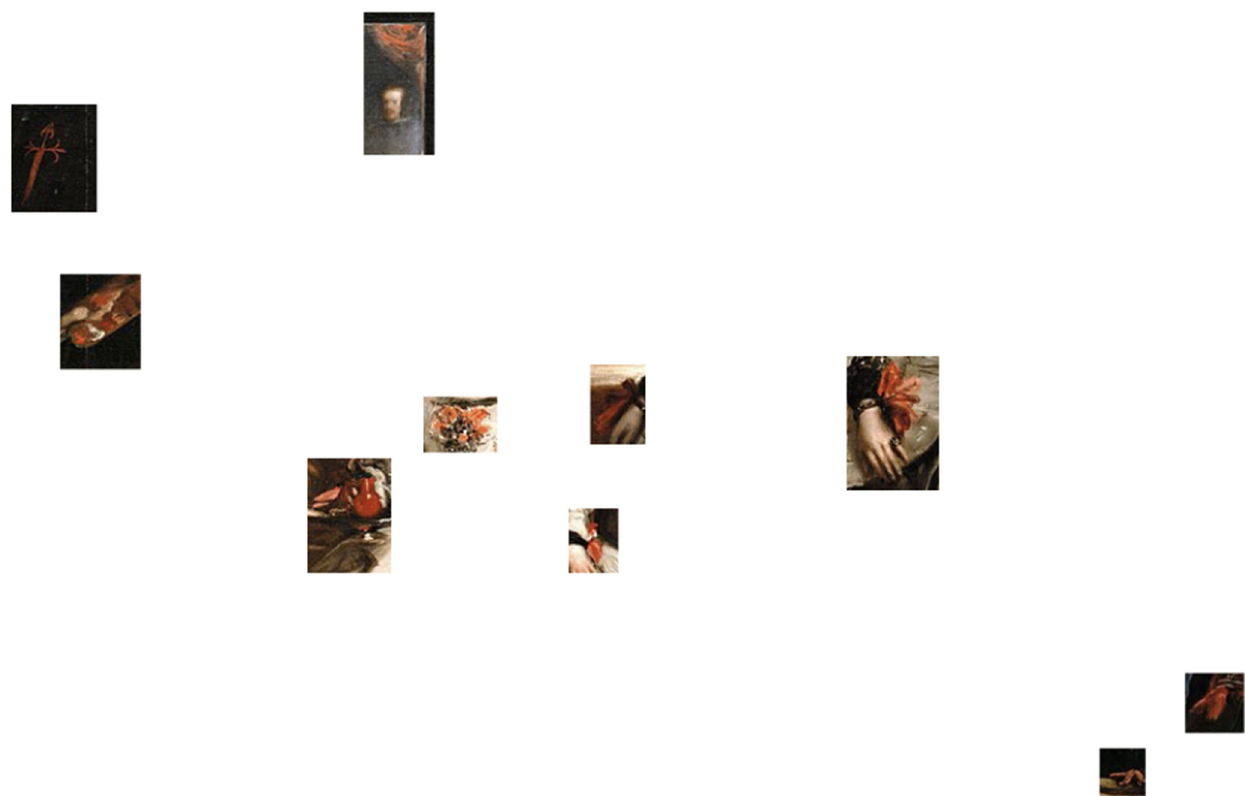
Figure 11. Red, details (Velázquez 1656).